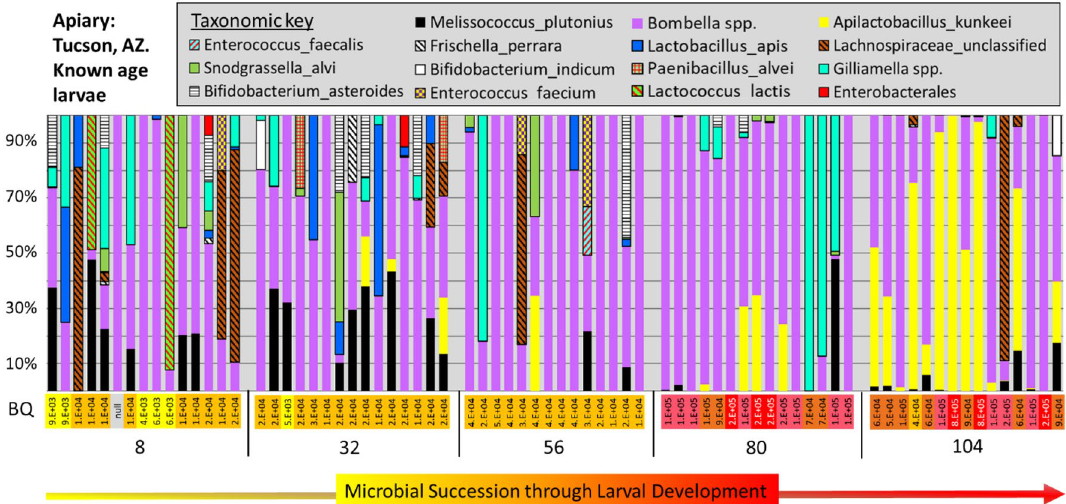
Figure 3. Microbial succession associated with healthy larval development sampling each 24 h to approximate zero to fourth instar. Results from an apiary in Tucson, AZ. with no history or recent evidence of European foulbrood disease. Data is from three colonies, five reps per day per colony, yielding n = 15 for each larval age (x-axis). Estimated average hours after egg hatch (range = ± 8 h) is listed across the x-axis. Individual larval microbiotas are displayed as relative abundance bar charts (y-axis), and BactQuant (BQ) values estimating microbiome size are displayed as a log notation heatmap vertically across the